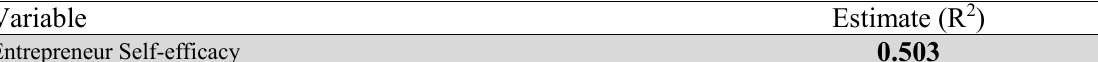
Squared Multiple Correlations (R 2 )